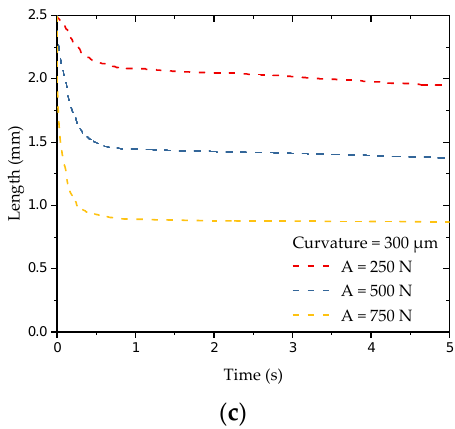
Figure 8. Predicted 𝐿 𝑛 of simple shear flow simulation at varying excluded volume force constant A with three critical curvature from: ( a ) 200 μm , ( b ) 250 μm , ( c ) 300 μm .